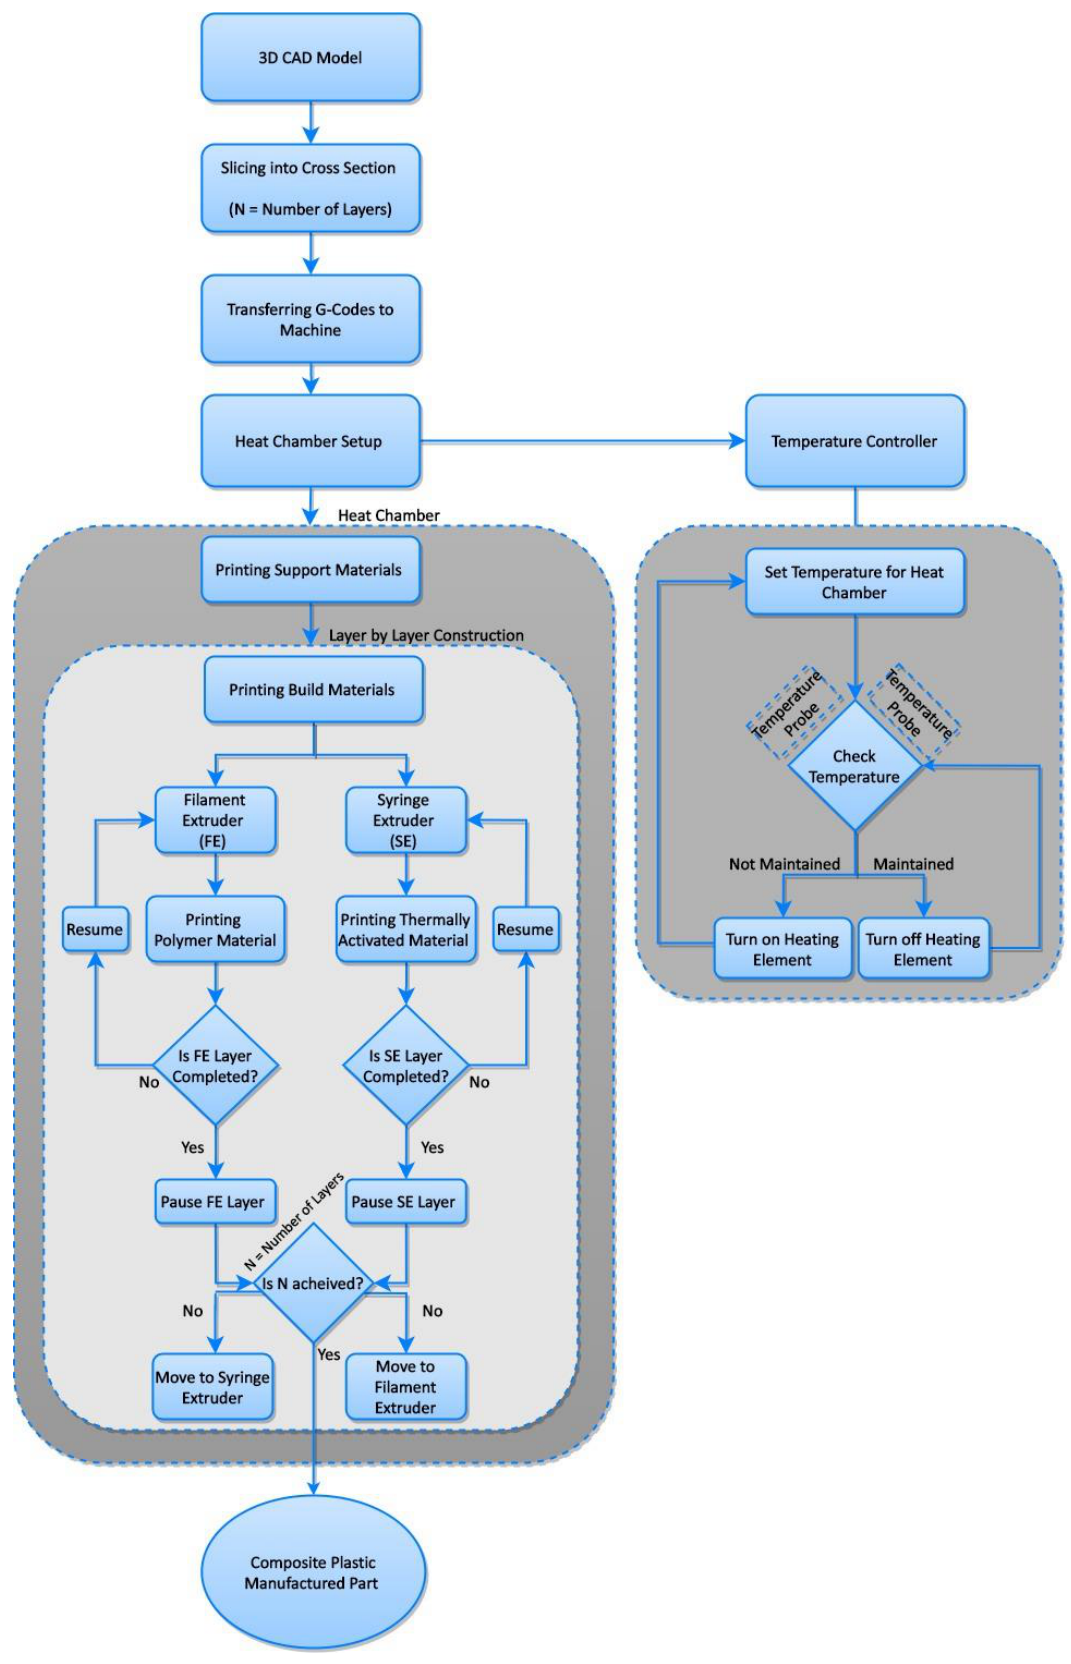
Figure 2. Flowchart of CPM process.